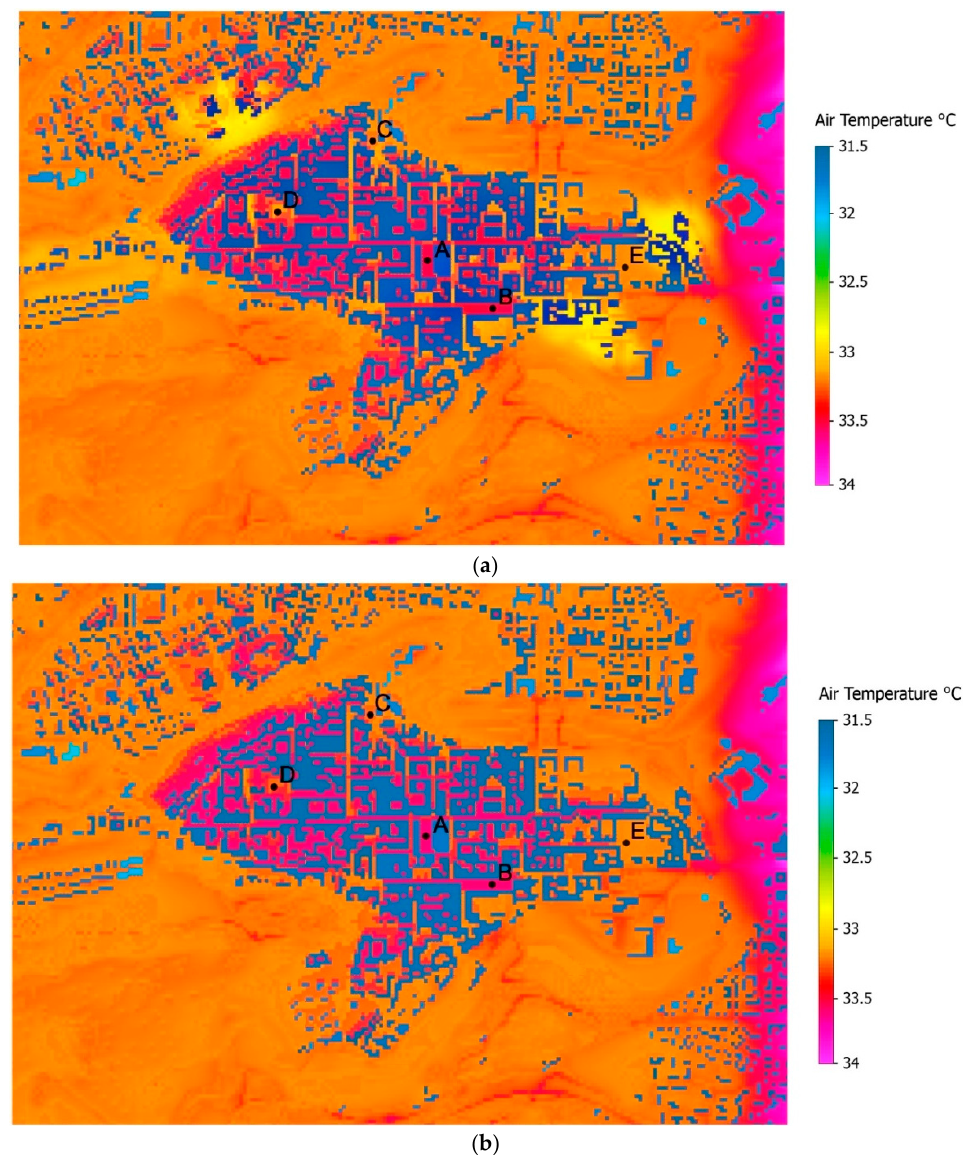
Figure 18. Temperature tomographies before and after intervention, in the whole city of Ascoli Piceno (before-intervention temperatures at the top ( a ) and after-intervention temperatures on the bottom ( b